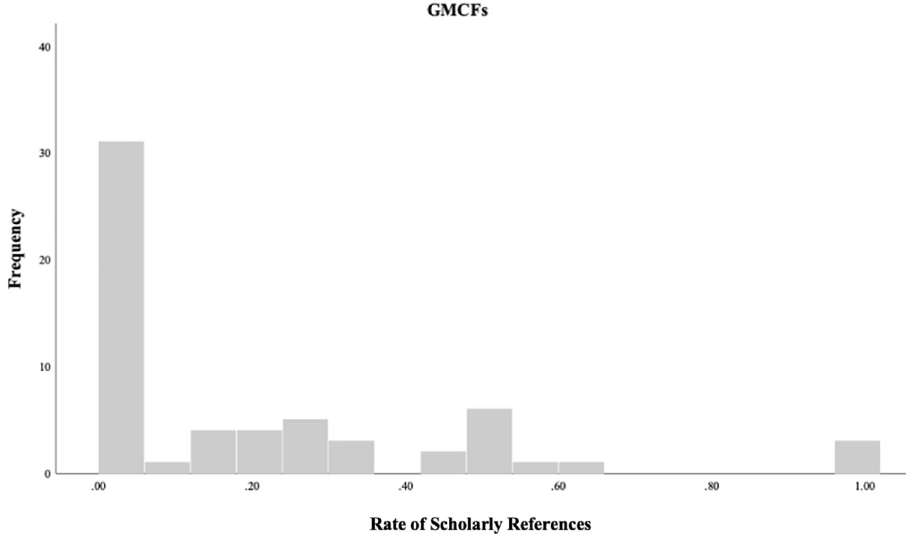
Fig 4. Distribution of scholarly references by GMCFs.